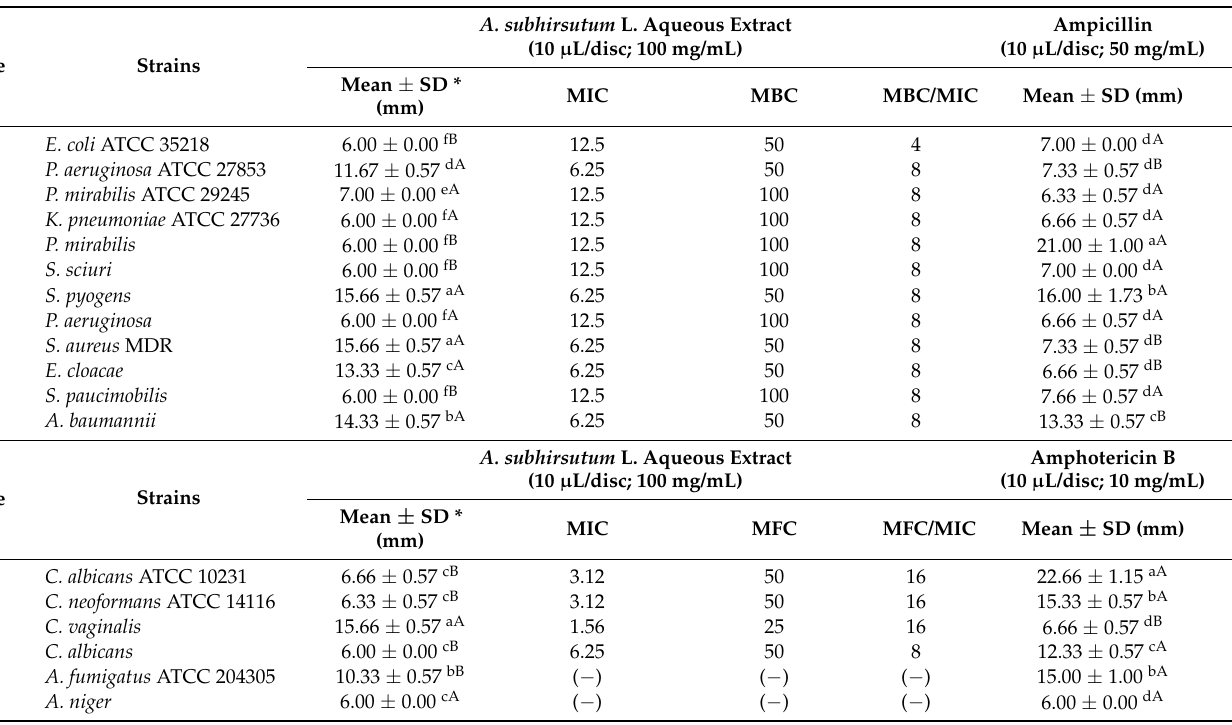
Table 2. Growth inhibition zone, as well as MIC, MBC, and MFC/MIC values obtained for all microorganisms tested using disc diffusion and microdilution assays tested using hairy garlic aque- ous